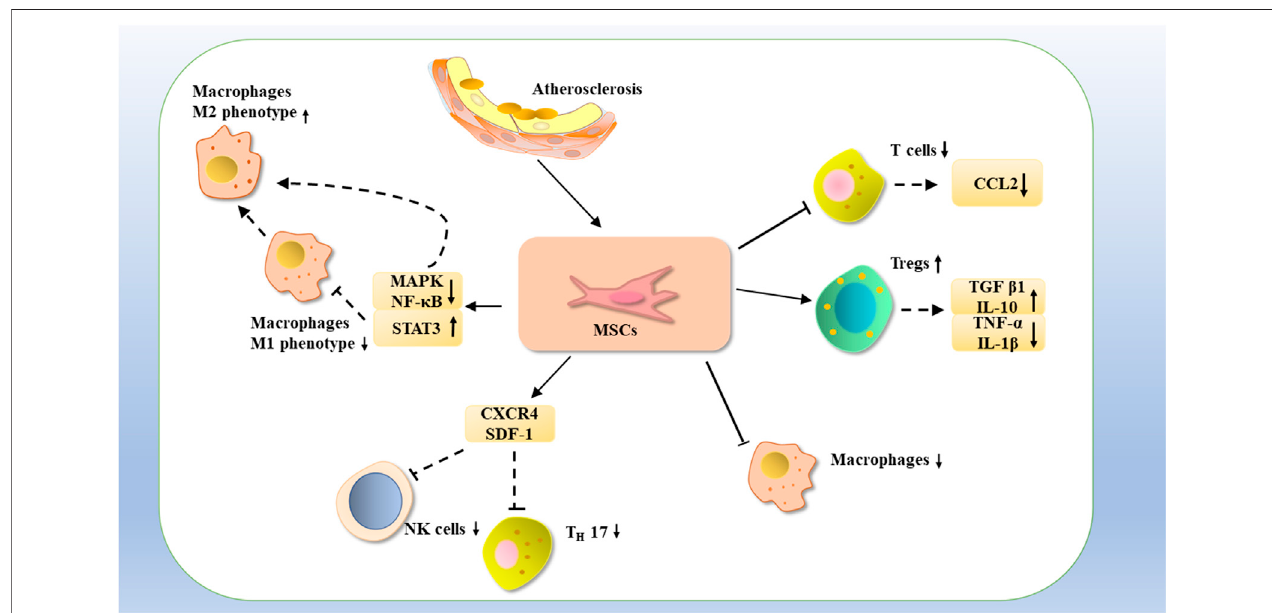
FIGURE 4 | MSCs may treat atherosclerosis by inhibiting the proliferation of T cells with CCL2 expression, or by increasing the number of Tregs, increasing the expressionofTGF- β 1andIL-10,decreasingtheexpressionofTNF- α ,andIL-1 β ,aswellasbyreducingthenumberofmacrophages.Atherosclerosiscouldbetreatedby inhibitingNKcellswithTH17throughCXCR4andSDF-1anddownregulatingMAPKandNF- κ BandupregulatingSTAT3expression,therebyinhibitingNKcellsM1-type macrophages and promoting the phenotypic transformation of M1-type macrophages to M2-type